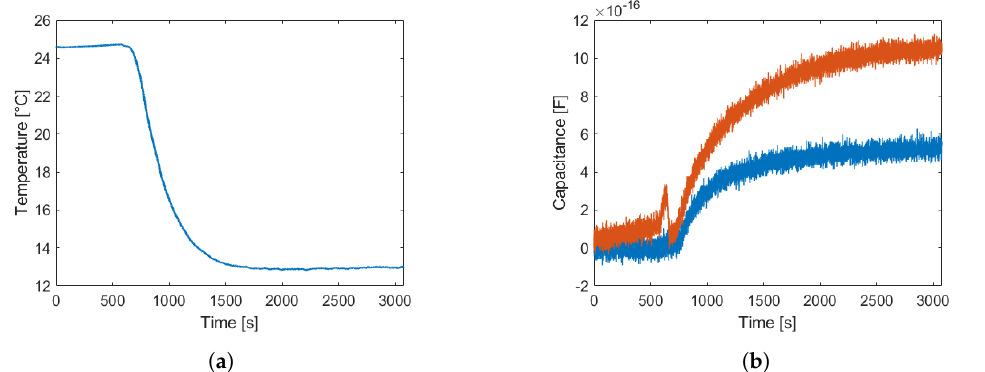
Figure 8. Temperature sensitivity experiments. In ( a ) the temperature variation to which the sensor was exposed to is shown and in ( b ) the measured capacitance difference